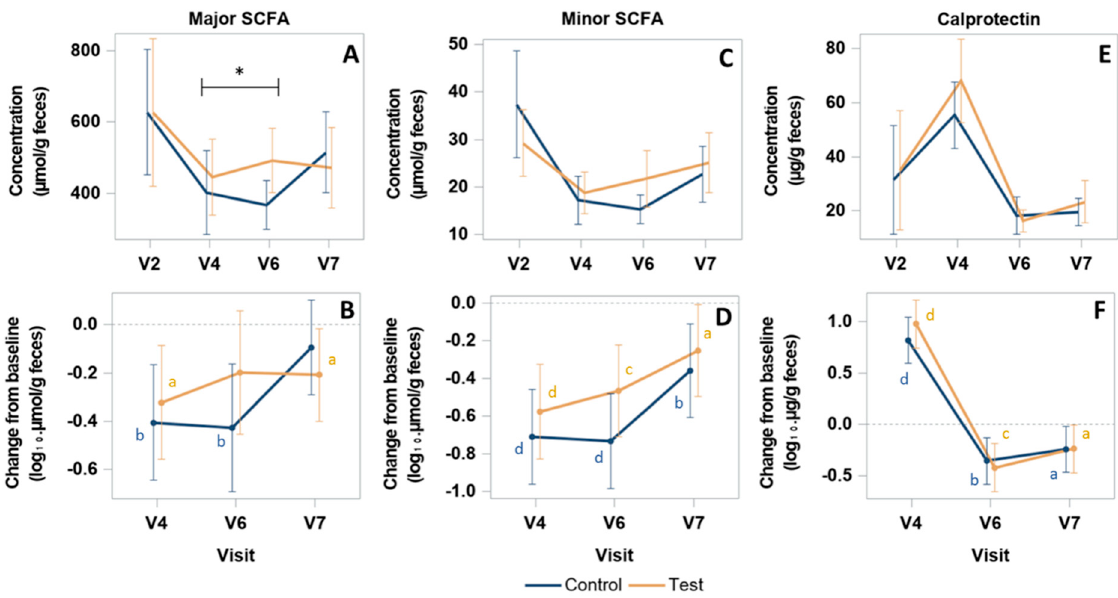
Figure 5. Quantification of fecal major/minor SCFA and Calprotectin. Concentration ( A , C , E ) and change from baseline ( B , D , F ) of major SCFA (acetate, propionate, butyrate) ( A , B ), minor SCFA (valerate, caproate, isobutyrate, and isovalerate) ( C , D ) and Calprotectin ( E , F ). p -values are provided according to Student test: * p < 0.05 for comparison between groups of the change of major SCFA concentration from V4 to V6; a p < 0.05, b p < 0.01; c p < 0.001; and d p < 0.0001, for comparison within group of the change from V2 at each visit. SCFA concentrations are expressed in µ mol/g of dry